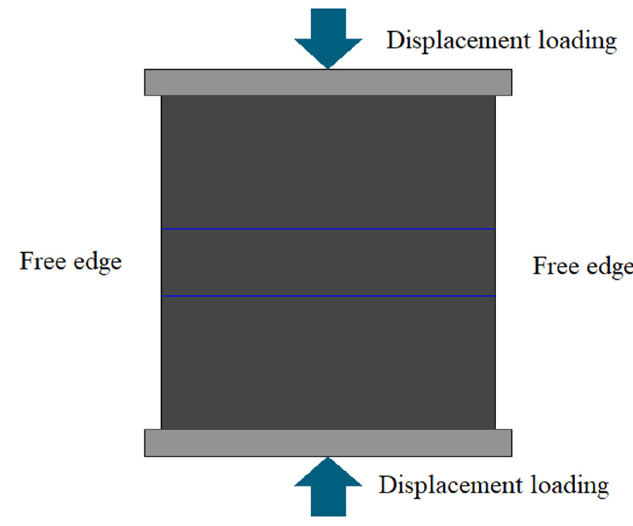
Figure 3. The loading method and boundary control diagram.